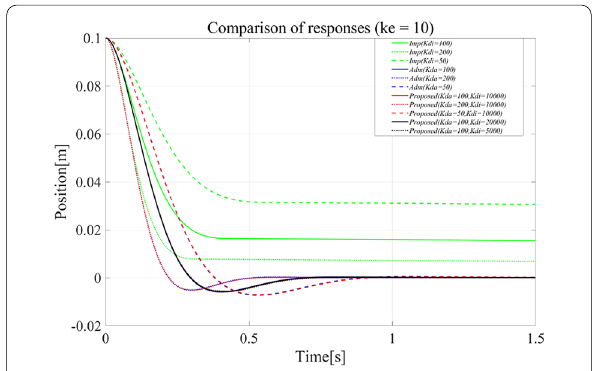
Fig. 6 Transient response of x in k e =